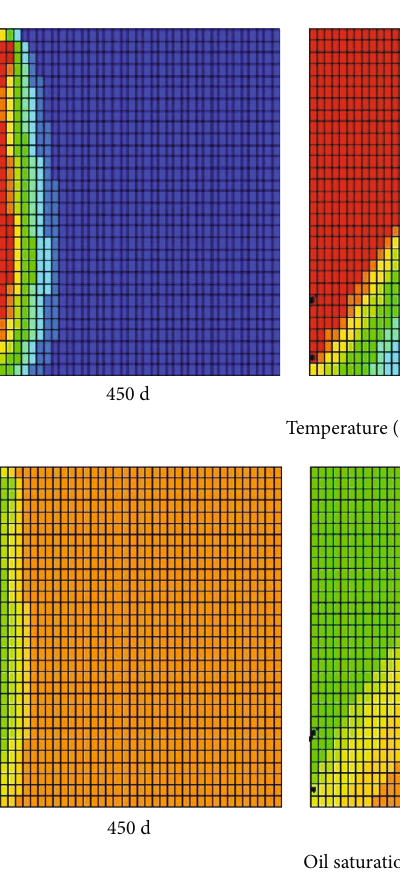
Figure 4: Temperature pro fi le and oil saturation pro fi le at di ff erent times of model A ( I = 1